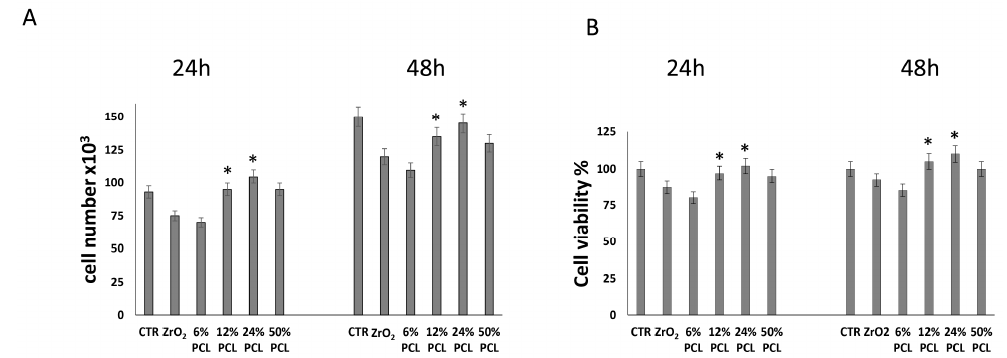
Figure 3. Effects of PCL-free ZrO 2 material, PCL/ZrO 2 hybrid materials with different percentages (6 wt %, 12 wt %, 24 wt %, 50 wt %) of PCL on cell proliferation. NIH-3T3 cells were cultured in 10% serum containing medium in the absence (control, CTR) or presence of the indicated substances for 24 and 48 h. Then, the cell number was recorded ( A ); and cell viability was measured by MTT assay ( B ). Data represent the average of three independent experiments. The means and S.D. are shown. * p < 0.05 vs. PCL-free ZrO 2 treated-cells.